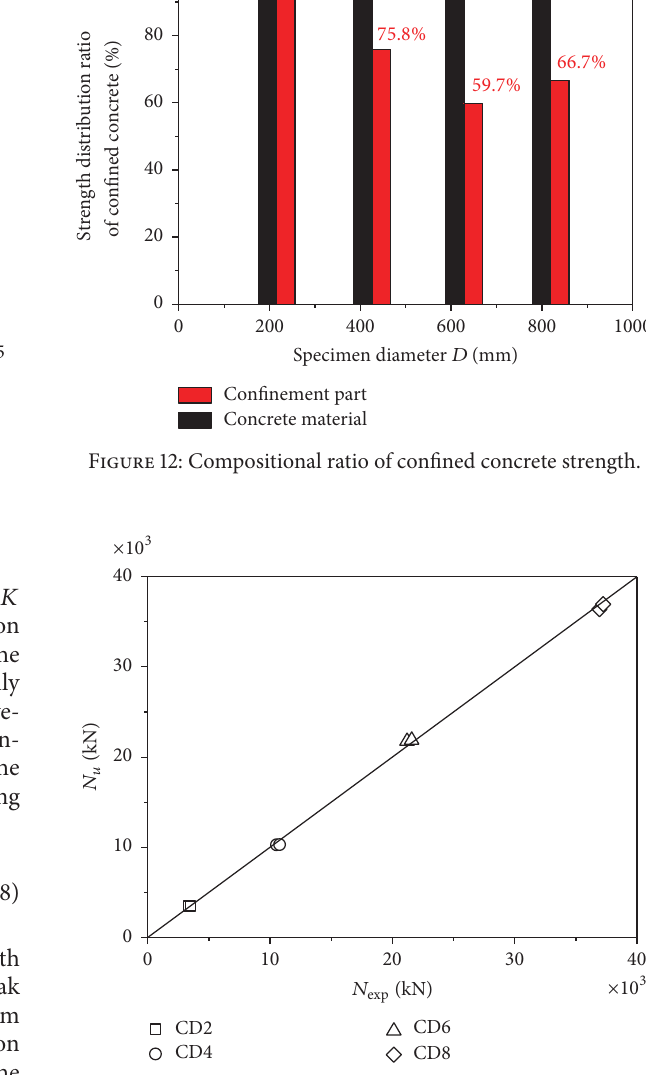
Figure 13: Comparison of experimental results and proposed